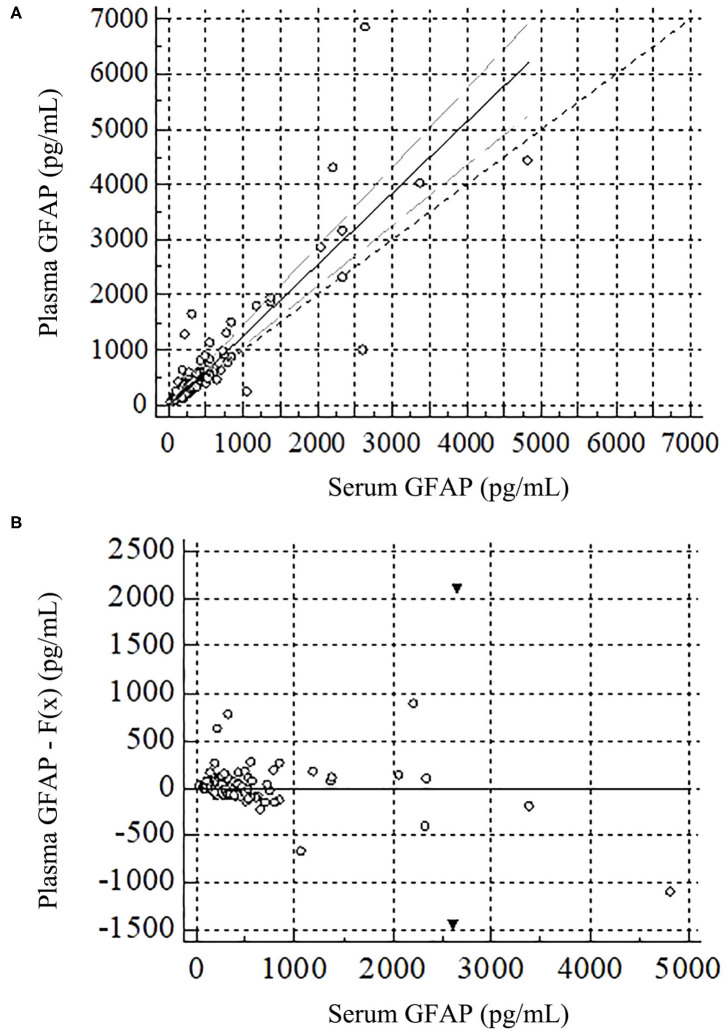
Passing and Bablock regression for plasma and serum GFAP in the total sample. GFAP, glial fibrillary acidic protein. (A) Scatter diagram with regression line, confidence intervals, and diagonal line is in the upper figure. (B) This residuals plot, in the lower figure, presents the distribution of difference around the fitted regression line, allowing a visual evaluation of the goodness of fit of the linear model. The residuals are the differences between the predicted values and the observed values for the dependent variable. The black triangles represent two extreme values.